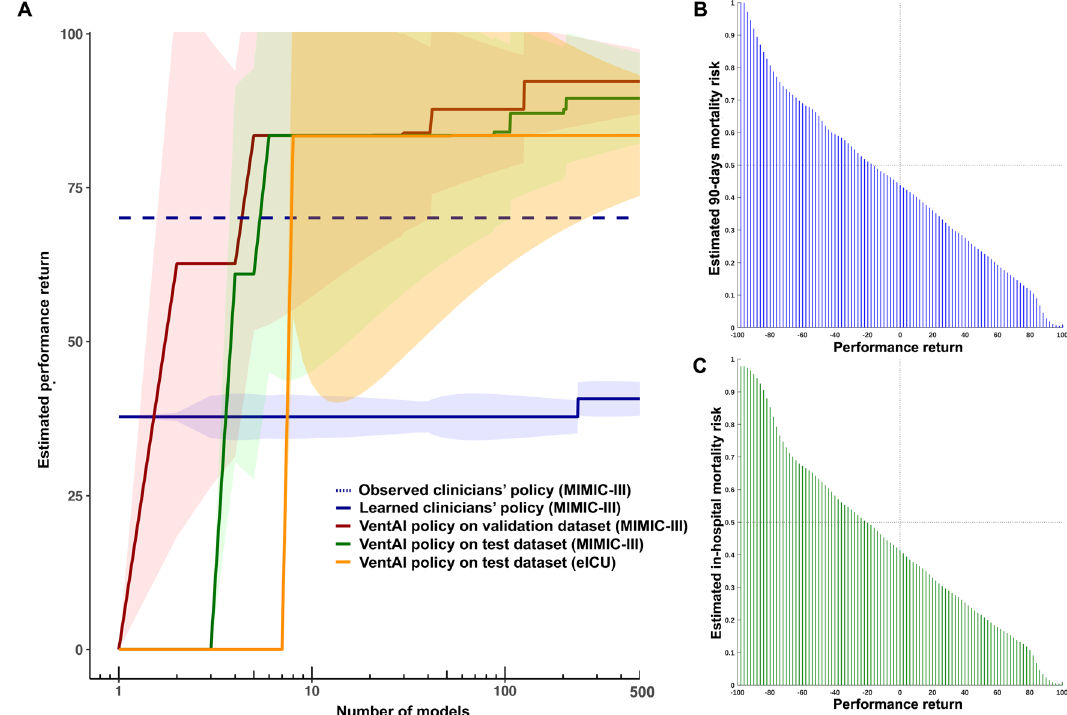
Fig. 2 VentAI Performance. a VentAI estimated performance return on both datasets (MIMIC-III and eICU) versus clinicians ’ performance return with variance in MIMIC-III dataset after the exposure of the policies to 500 models. b Relation between VentAI performance return and estimated 90-day mortality risk in the MIMIC-III dataset. c Relation between VentAI performance return and in-hospital mortality risk in the eICU